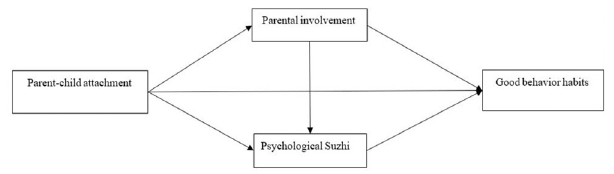
Fig 1. The proposed mediating